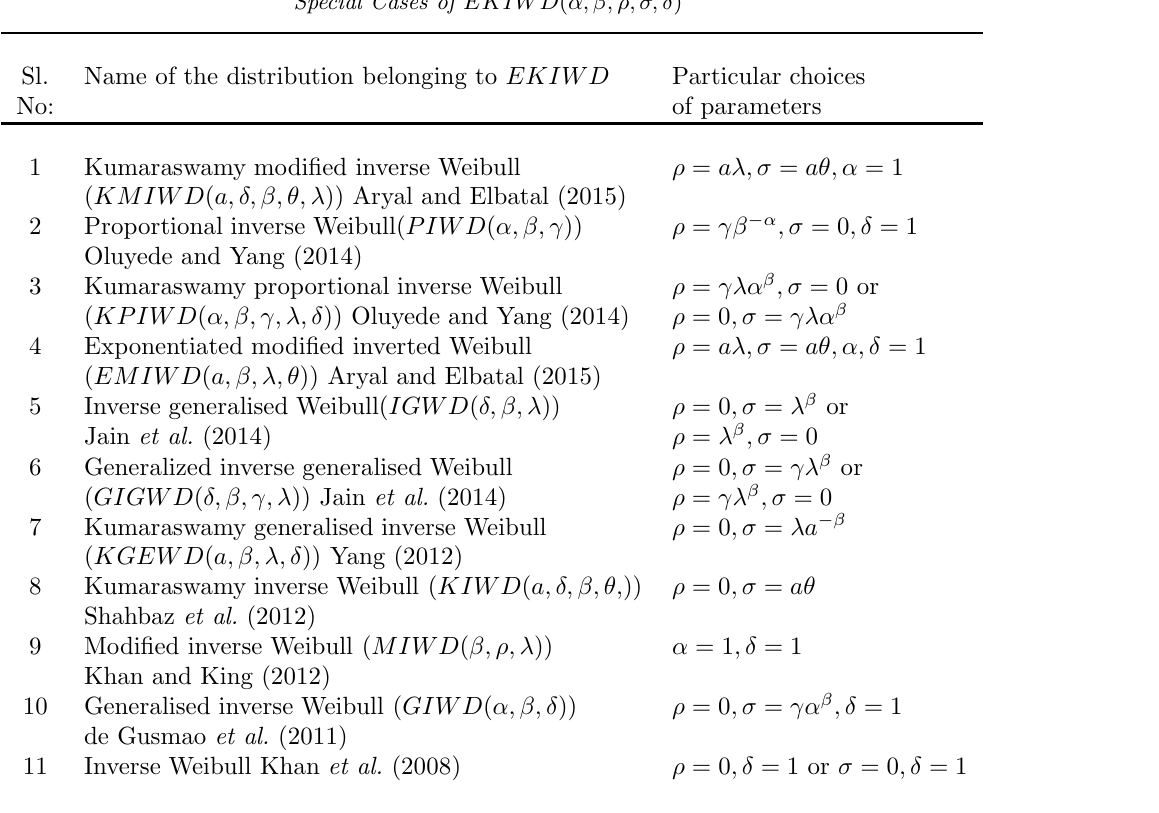
Special Cases of EKIWD ( α,β, ρ,σ, δ